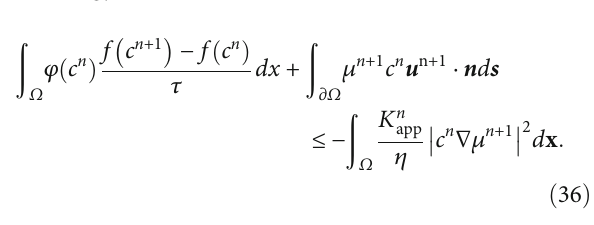
Figure 16: The cumulative production under di ff erent values of c